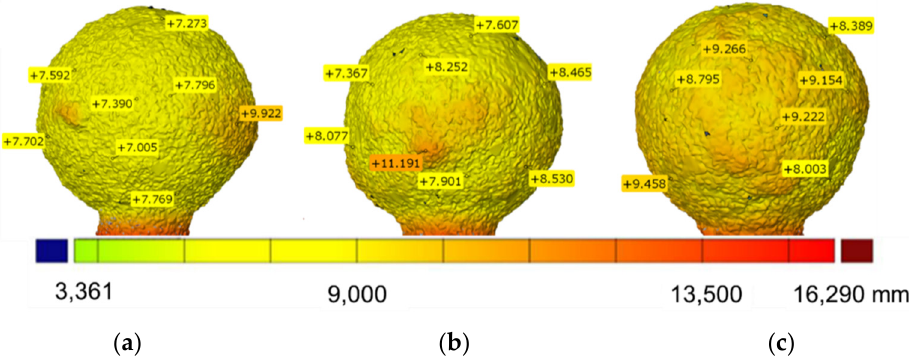
Figure 10. Thickness of the ceramic samples determined by the 3D scanning: M1 ( a ), M2 ( b ) and M3 ( c